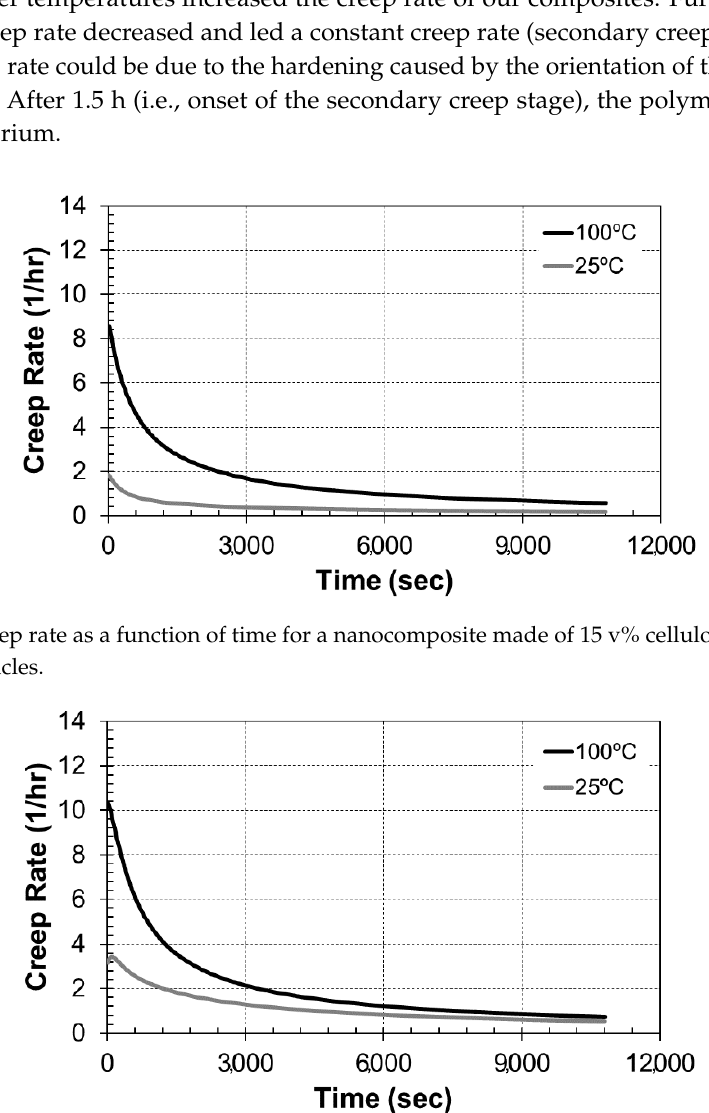
Figure 18. Creep rate as a function of time for a nanocomposite made of 15 v% cellulose and 20 wt. % STO nanoparticles.